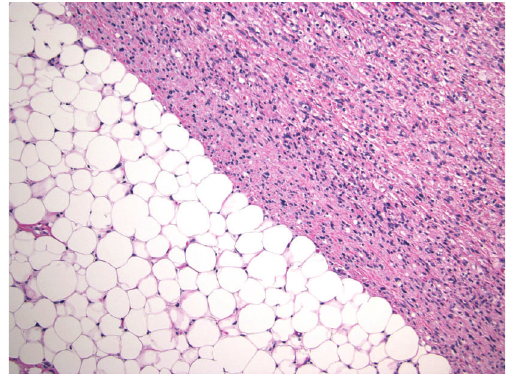
Figure 2: The interface between the well-di ff erentiated and dedif- ferentiated components.